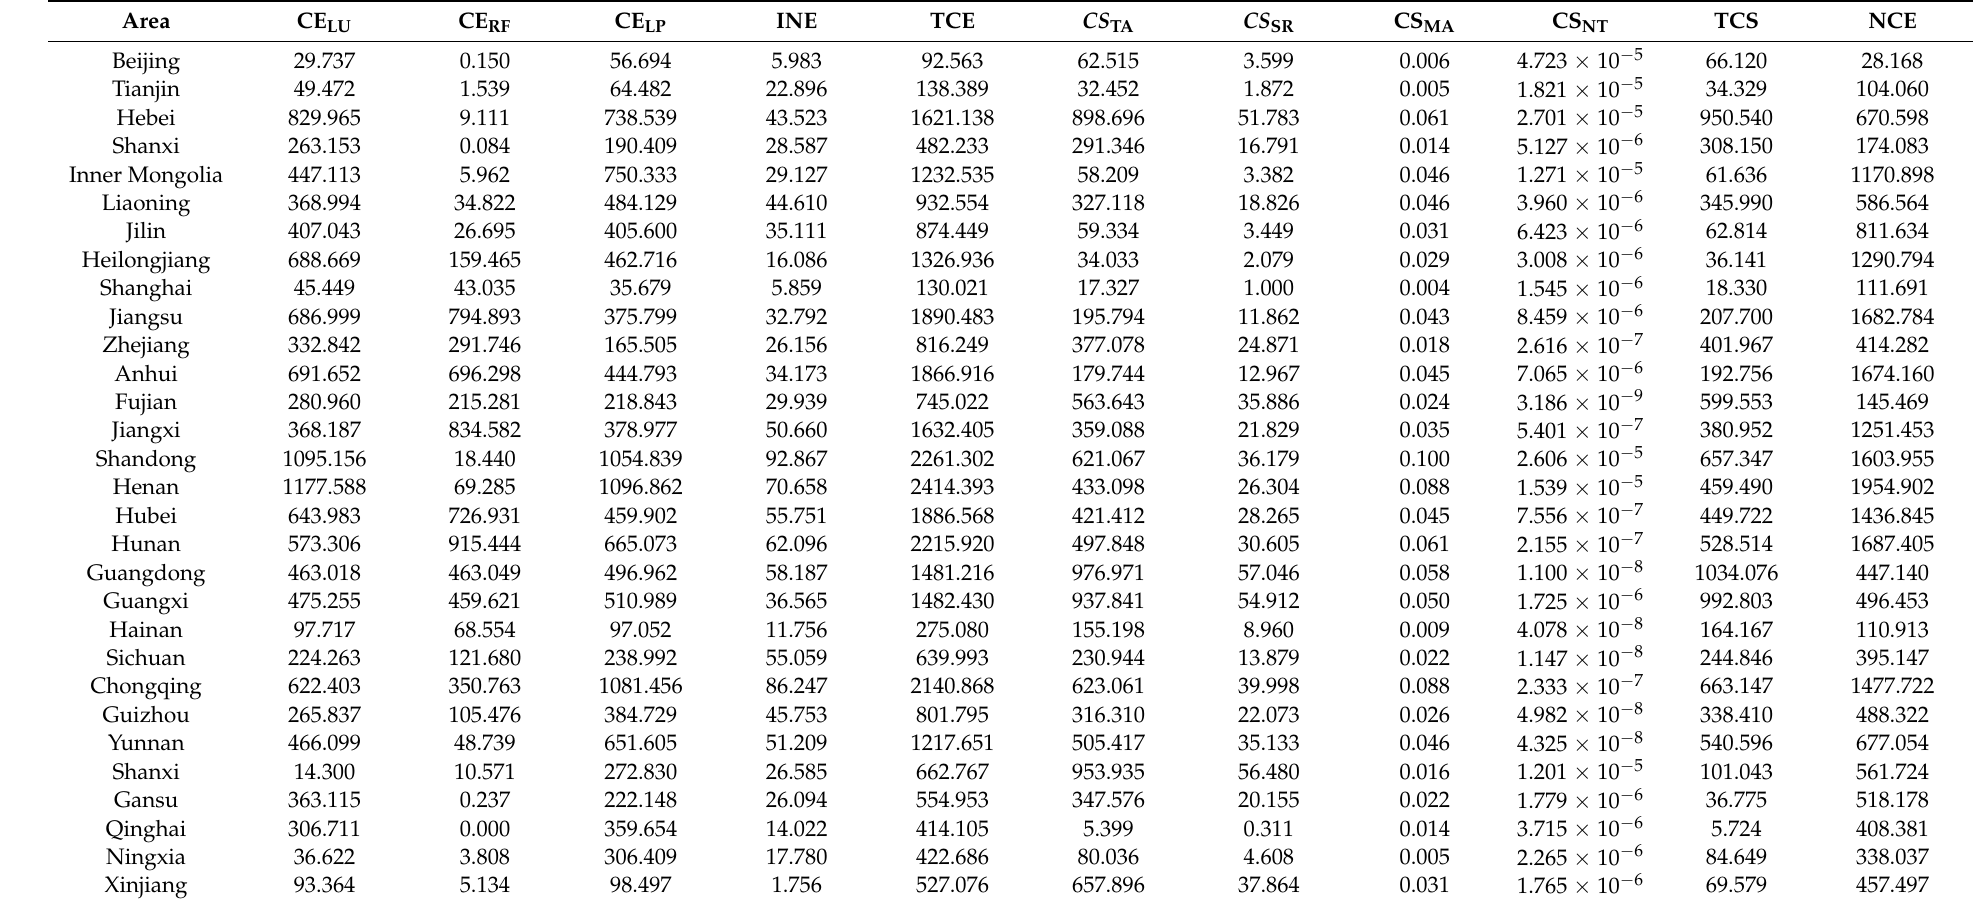
Table 2. Total agricultural net carbon emissions in China’s provinces in 2000–2019. Unit: 10,000